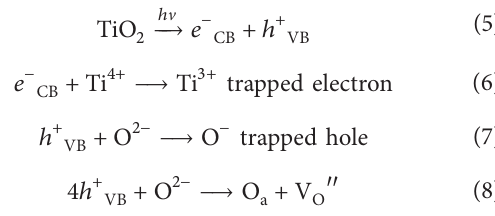
H 2 treatment up to 700 ∘ C (Figure 4). As the temperature increased, more O a were removed by H 2 . Magnetic Ti